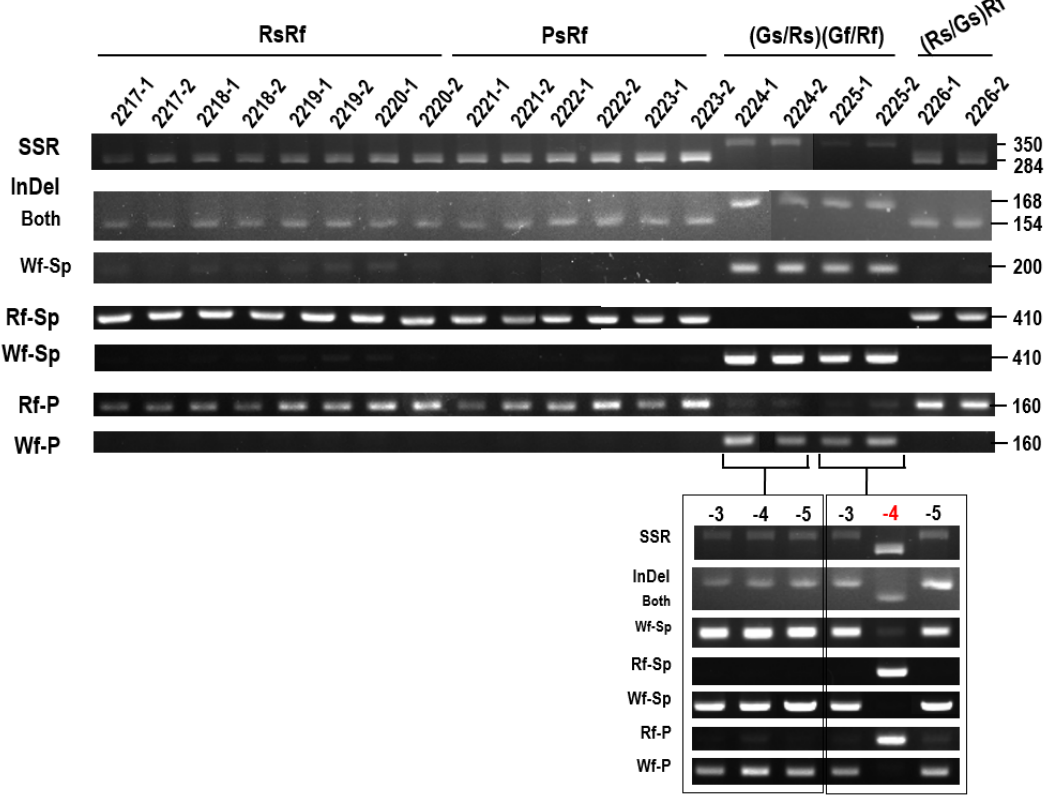
Figure 9. Validation of PCR-markers using newly developing radish lines in Sejong University. -P indicates the pink color and that lines were still segregated in terms of taproot color. Numbers on the right denoted size of band (bp). 2219 and 2221, F 4 generation; 2220, F 5 generation; 2217 and 2218, F 6 generation; 2223–2226, F 10 generation; 2222, F 11 generation.